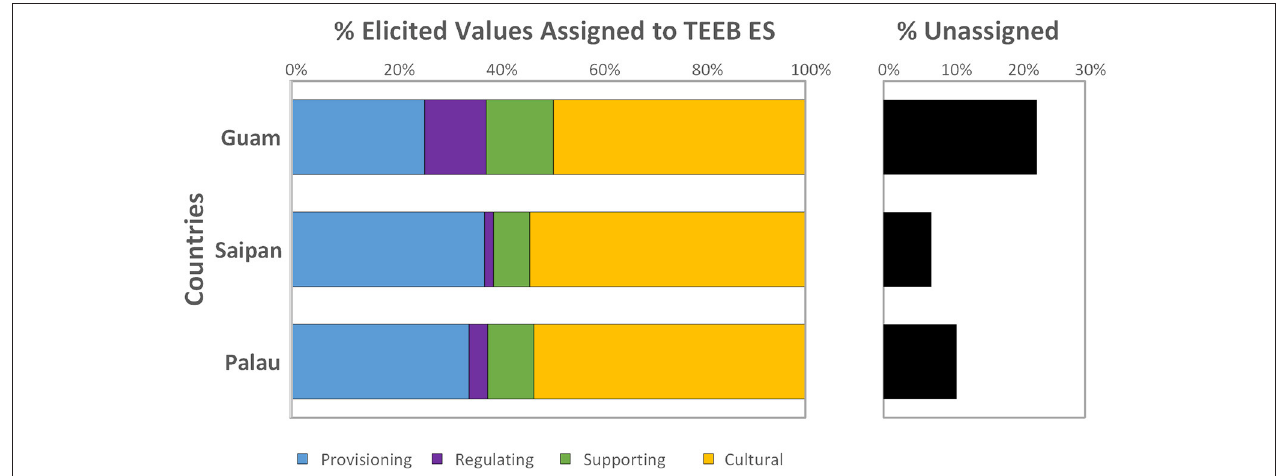
FIGURE 6 | Alignment of values with The Economics of Ecosystems and Biodiversity Ecosystem Services (TEEB ES) framework. Note that unassigned values are percentages of the total number of values, whereas assigned values are percentages of total assigned